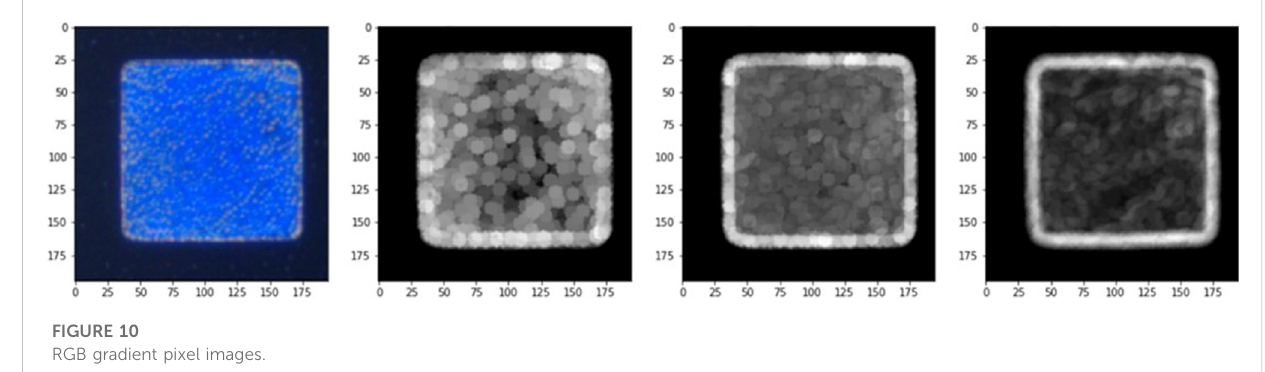
FIGURE 10 RGB gradient pixel